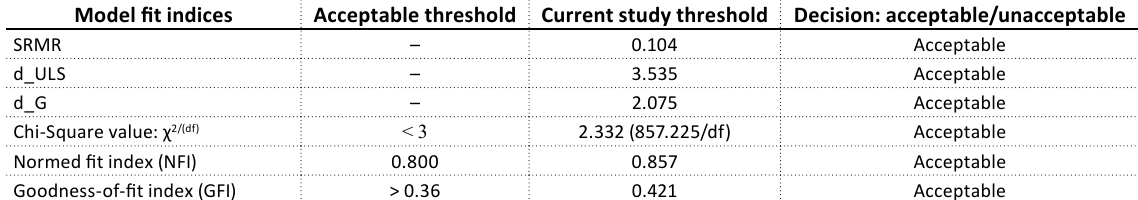
Table 4. Model fit